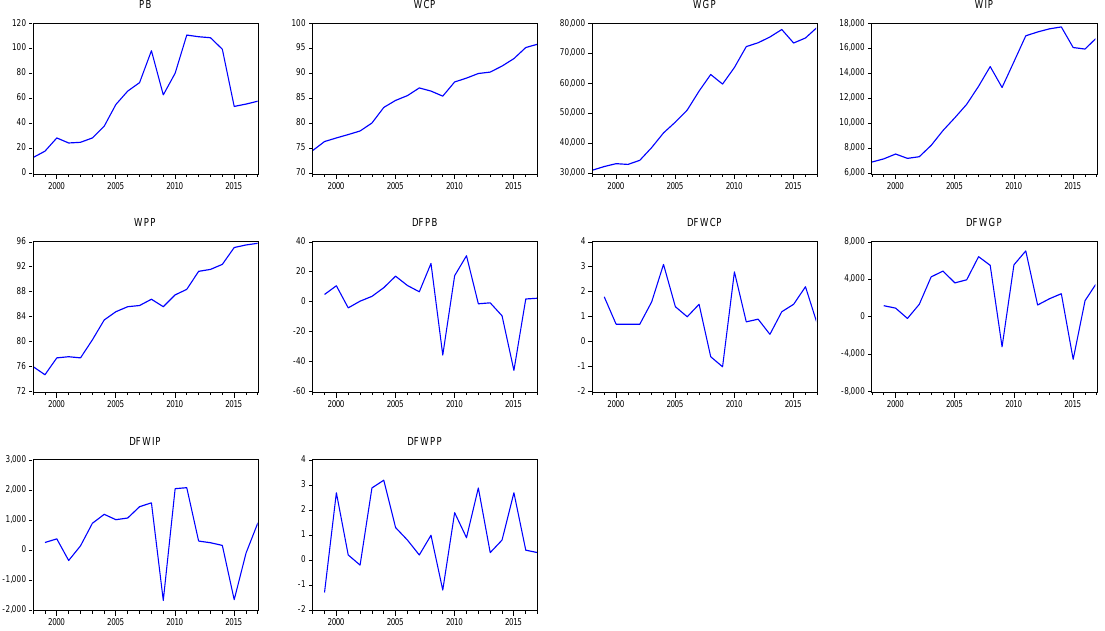
Figure A2. World GDP, industrial production, daily oil production, daily oil consumption and oil prices.